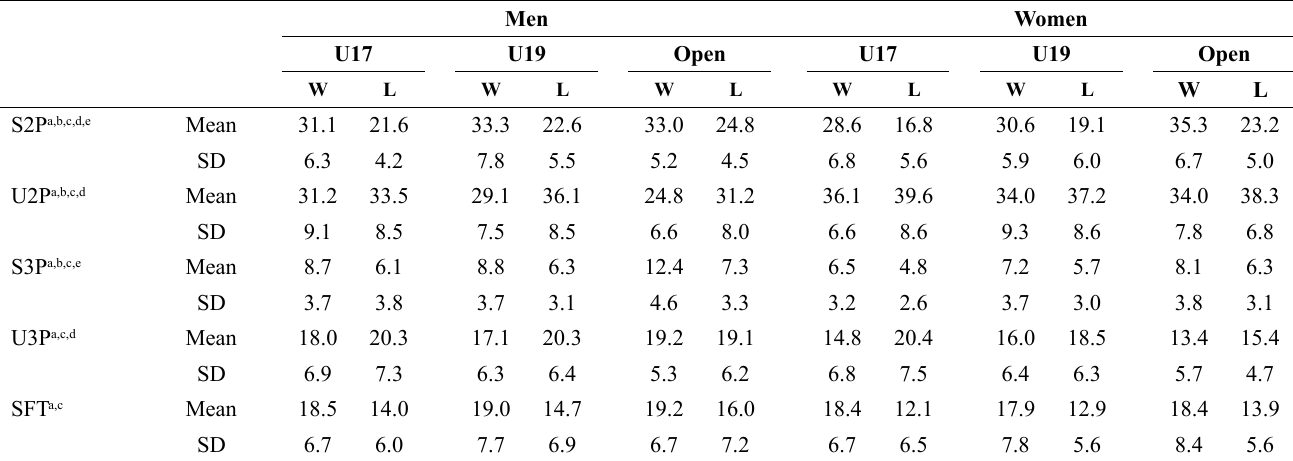
Table 3. Game-related statistics of unbalanced